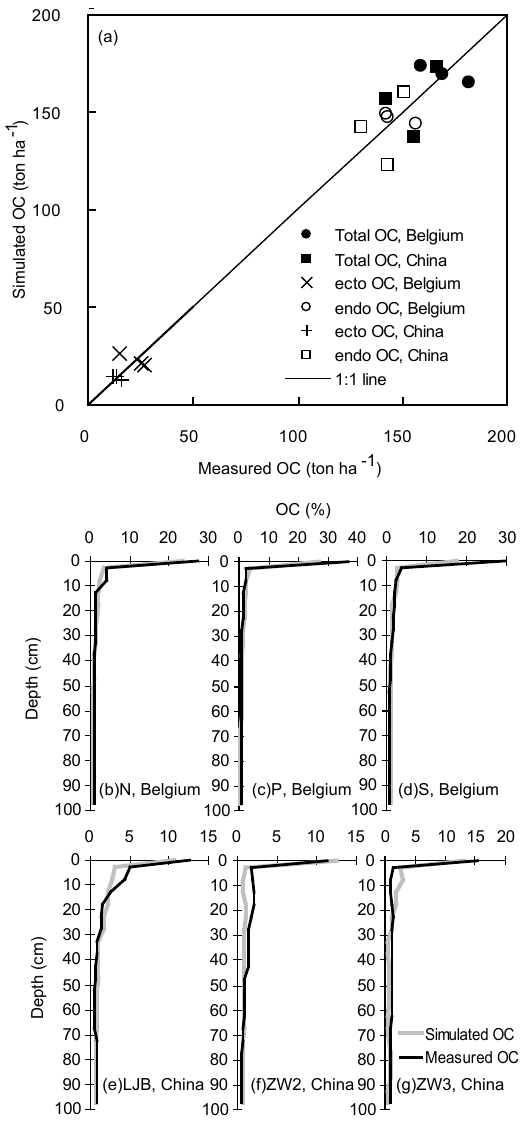
Fig. 6. Comparison of measured and simulated OC based on soil pedons for validation in Belgium and China. (a) OC mass in Bel- gium and China; (b) OC content of N pedon in Belgium; (c) OC content of P pedon in Belgium; (d) OC content of S pedon in Bel- gium; (e) OC content of LJB pedon in China; (f) OC content of ZW2 pedon in China; (g) OC content of ZW3 pedon in